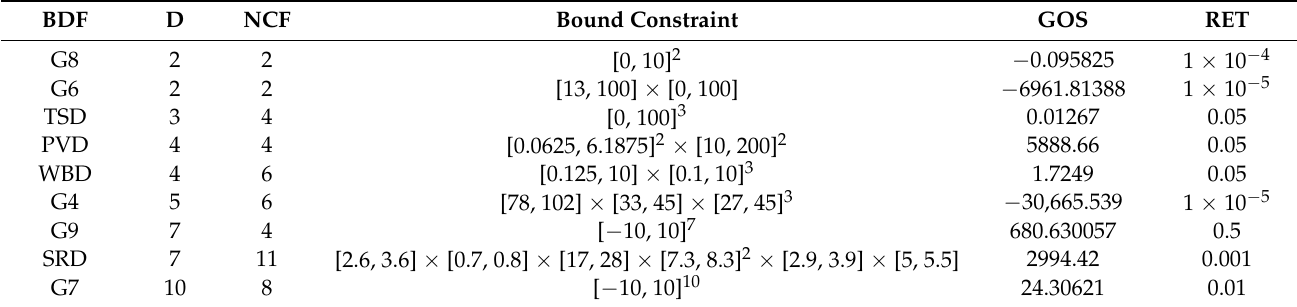
Table 3. The main information of test problems. It includes BDF (benchmark or design problems), D (dimension), NCF (number of constraint functions), bound constraint, GOS (global optimal solution), and RET (relative error threshold).